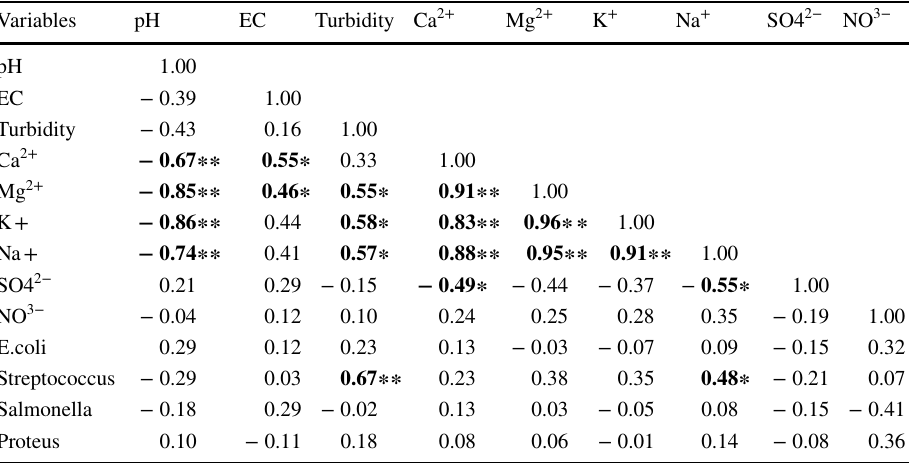
Table 5 Correlation among selected Mezam water characteristics for the studied period (n =